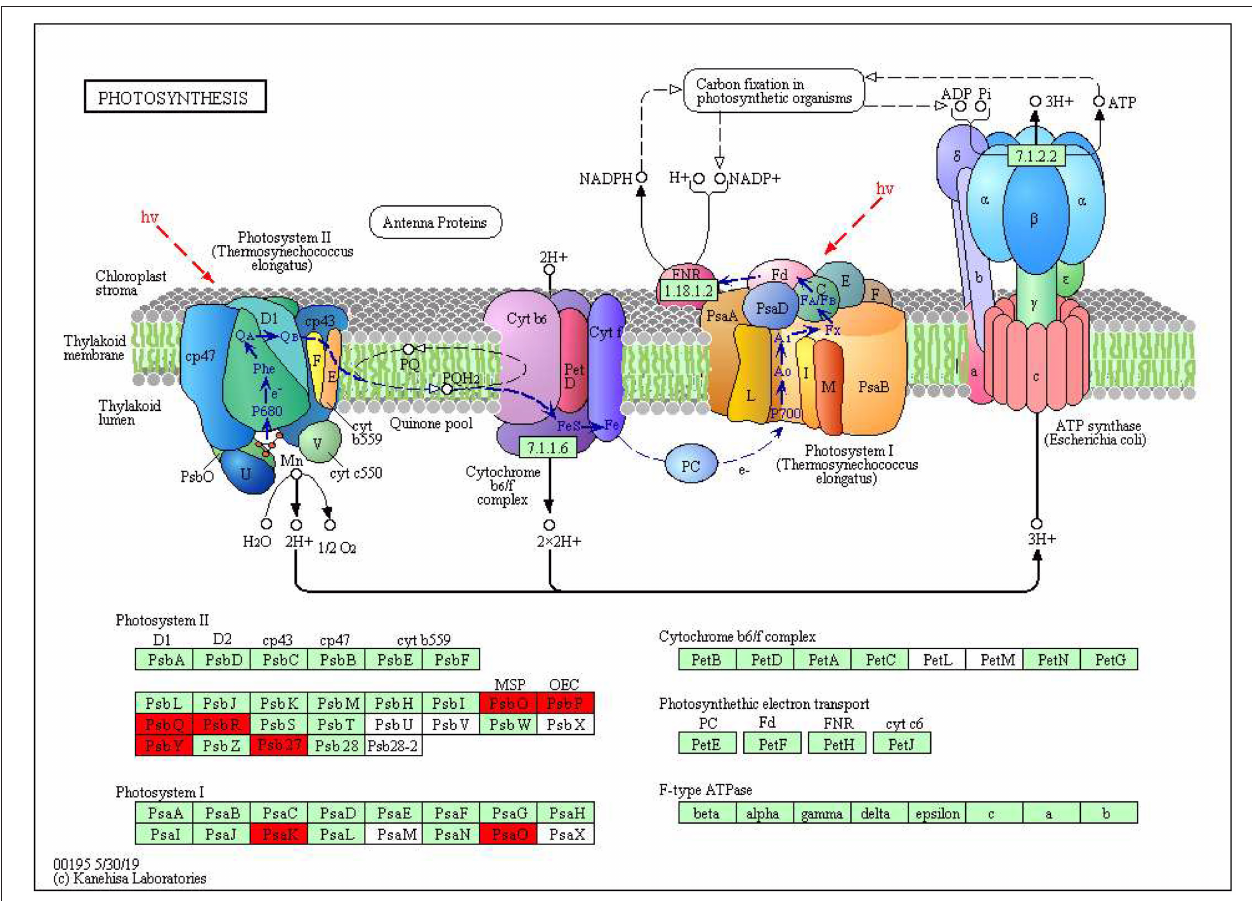
FIGURE 7 | Water deficit-affected subunits of photosystems in photosynthesis chain. (PsbO) Oxygen-evolving enhancer protein 1. (PsbP) Oxygen-evolving enhancer protein 2. (PsbQ) Photosynthetic NDH subunit of lumenal location 2. (PsbR) Photosystem II 10 kDa polypeptide. (PsbY) Photosystem II core complex proteins psbY. (Psb27) Photosystem II repair protein PSB27-H1. (PsaK) Photosystem I reaction center subunit psaK. (PsaO) Photosystem I subunit O. Red color represents significant and characterized enzymes based on Oryza sativa annotation. Green color represents significant and non-characterized enzymes. White color represents characterized enzymes based on Arabidopsis thaliana